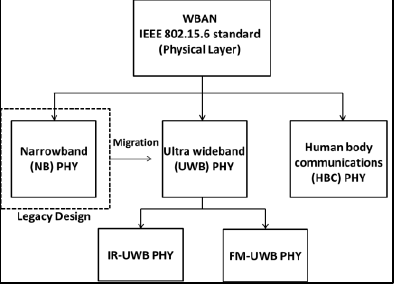
Figure 5. IEEE 802.15.6 Physical Layer